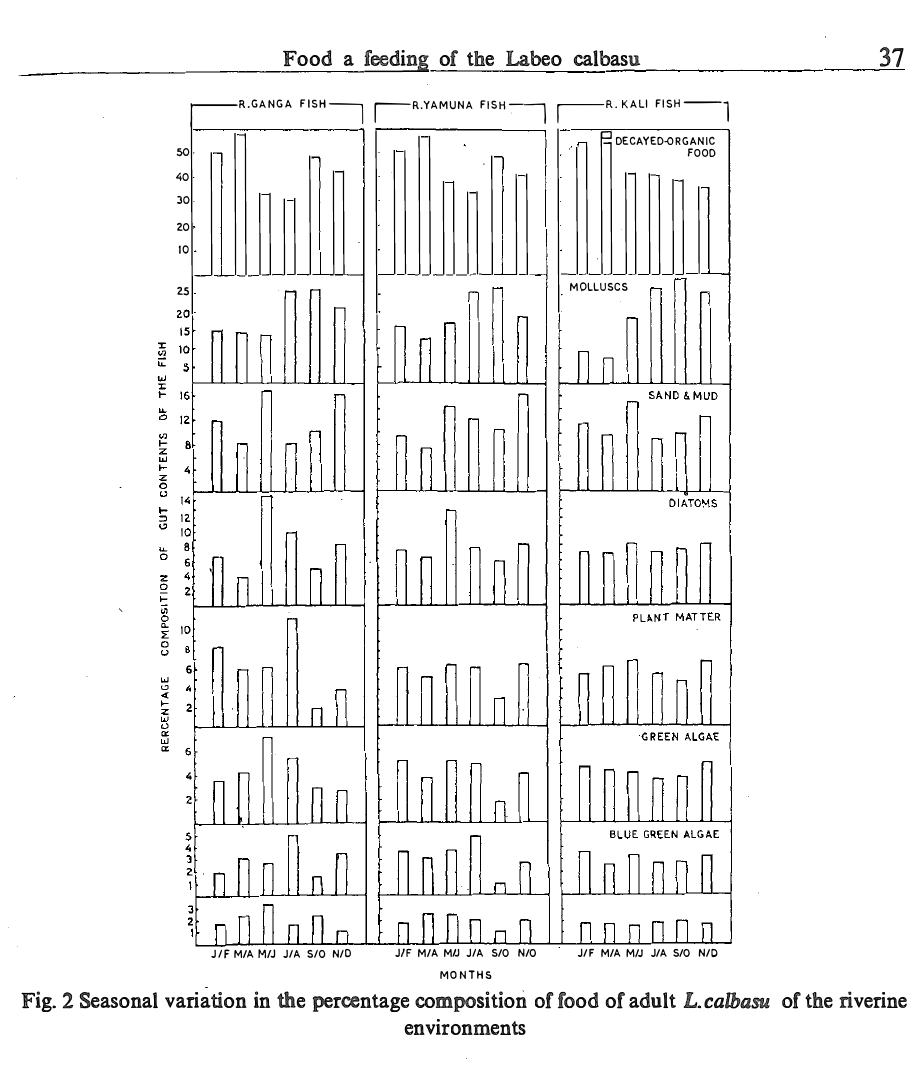
Fig. 2 Seasonal variation in the percentage composition of food of adult L. calbam of the riverine